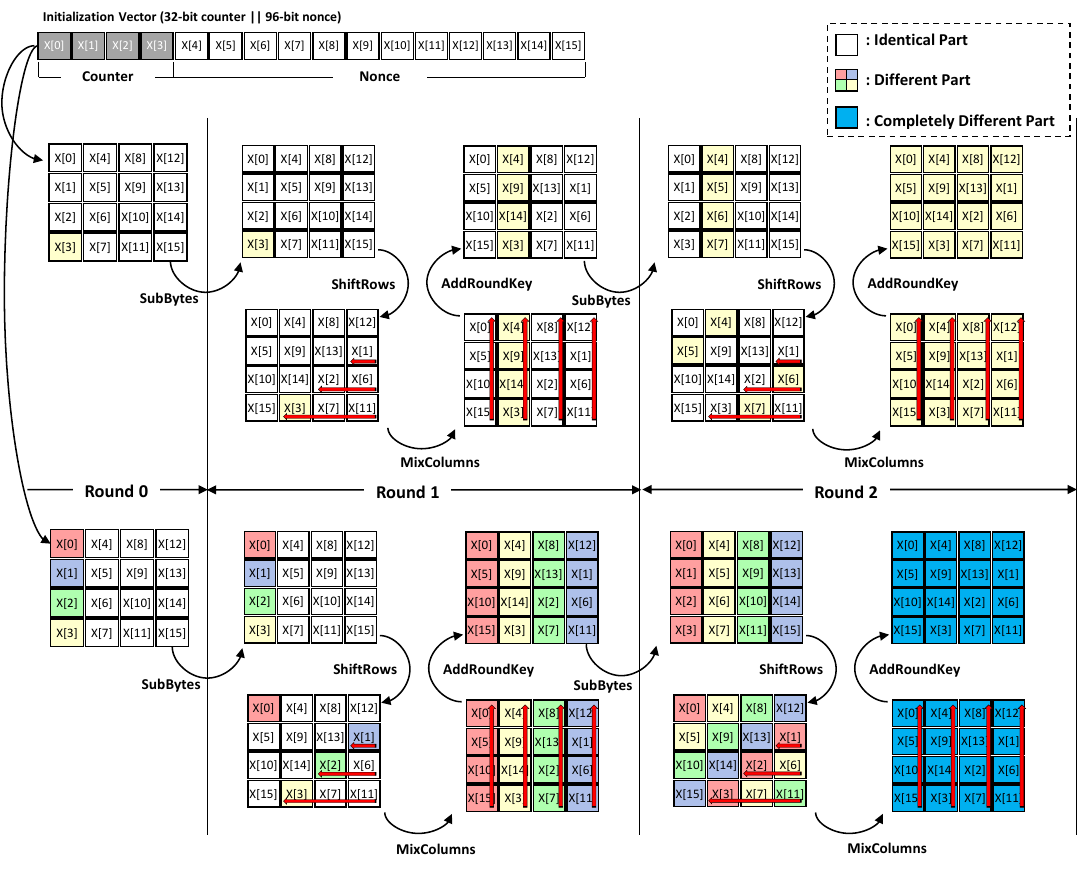
Figure 1. Overview of